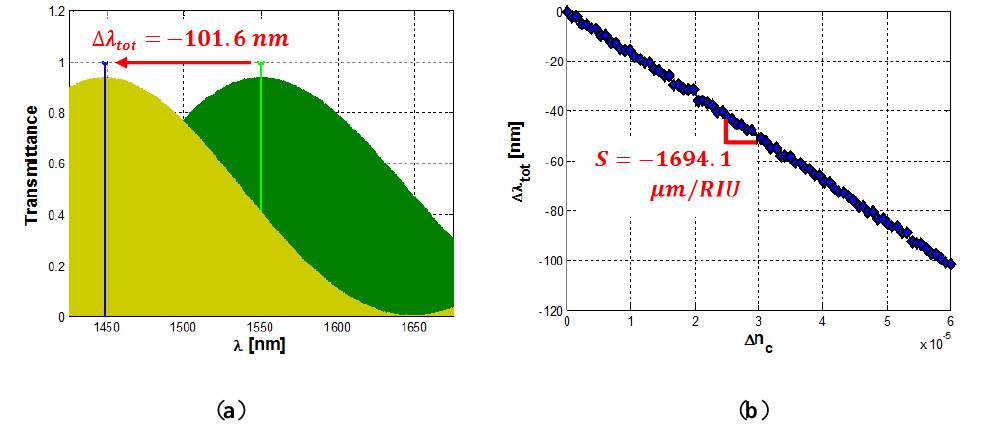
Figure 12. ( a ) Spectral response of a MZI enhanced Vernier effect based sensor at rest (green curve) and in the presence of the analyte to be detected (yellow curve); ( b ) Overall wavelength shift versus cladding refractive index